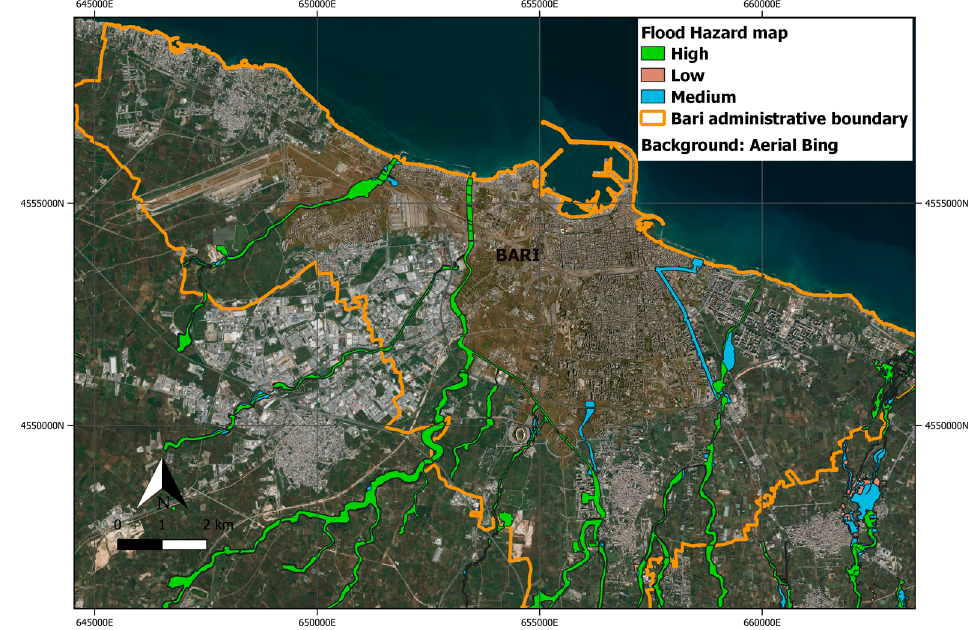
Figure 6. Map of flood hazard in Bari up-to-date to November 2019. Source: “Autorità di bacino distrettuale dell’Appennino Meridionale”. Background source: Bing Aerial.